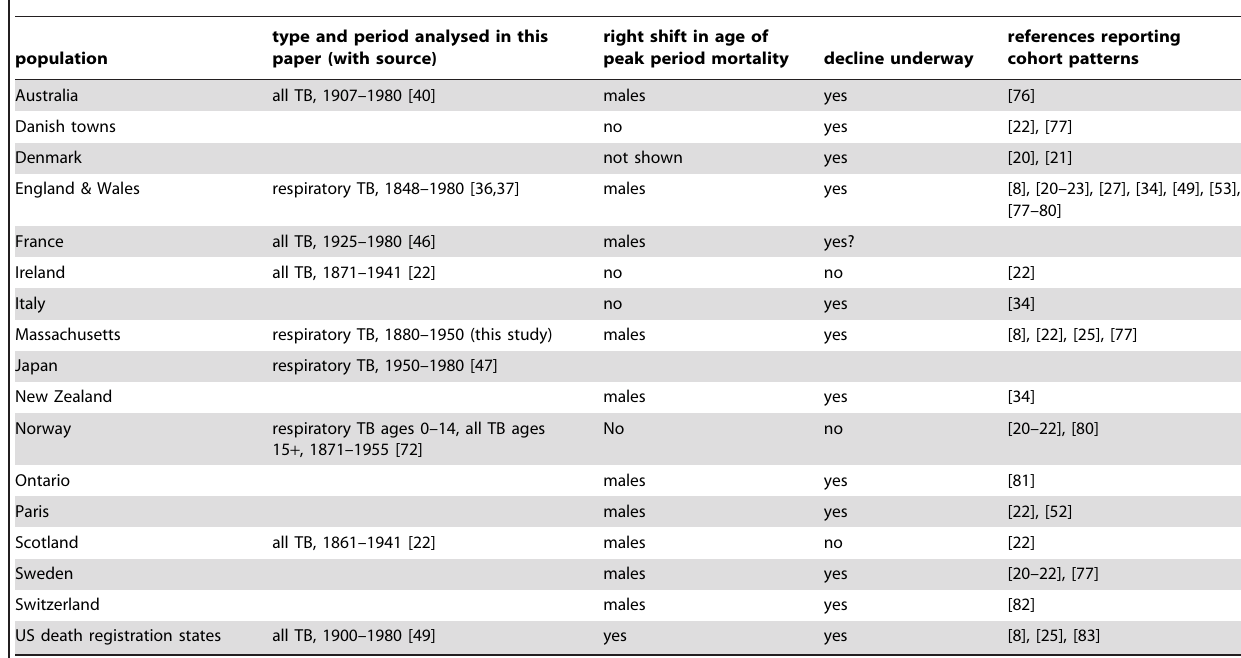
Table 1. Tuberculosis mortality data used in this and previous studies of cohort effects in tuberculosis.